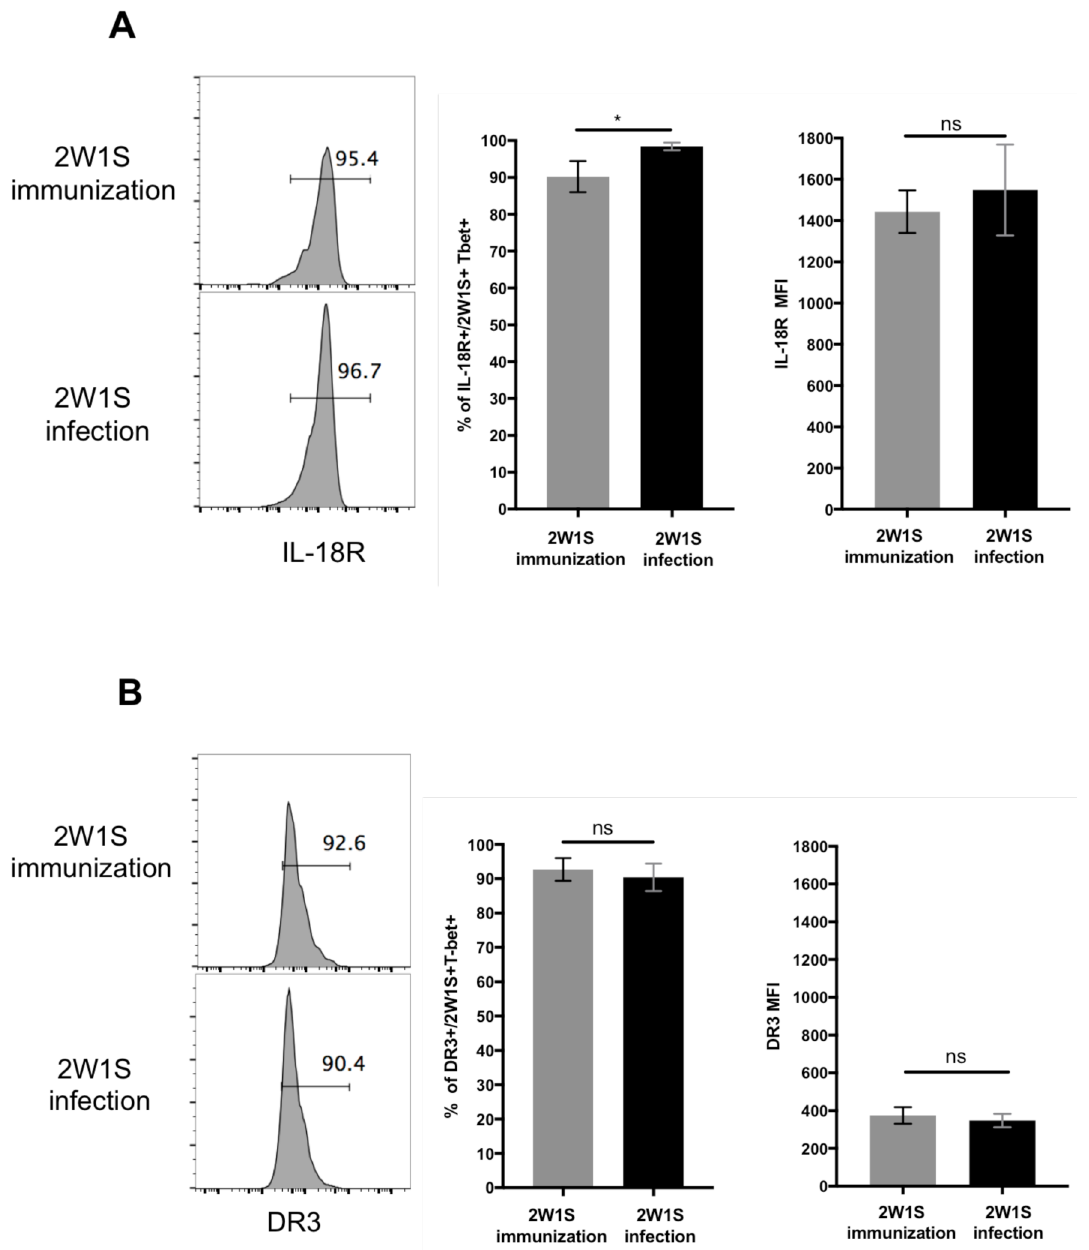
Fig 7. IL-18 and DR3 expression on Th1 cells. C57BL/6 mice were immunizedintravenously with a mixture 100ug of SseB-2W1S, 100ug flagellinand 10ugLPS twice at day 0 and day 28. As a positive control, C57BL/6mice were infected i.v. with 5 × 10 5 Salmonella Typhimurium (BRD509-2W1S) at day 28 . Two weeks later, spleenswere harvested to examine surface marker expressionon 2W1S-specific T-bet + cells. Representative flow cytometry plots and graphs of combineddata are shown for of IL-18R (A) and DR3 (B) expression. Data shown were combinedfrom two experiments containingat least three mice per group. Statistical analyseswere performed by two-way ANOVA with a Bonferroni posttest. Error bars represent the mean ±